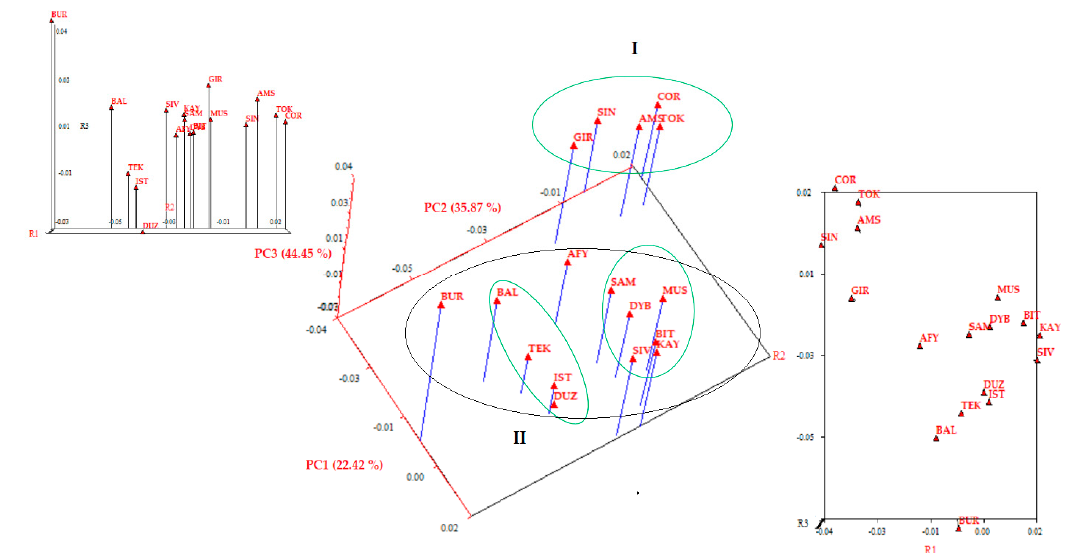
Figure 3. Tree ‐ dimensional principal component analysis (PCA) plot of Turkish water buffalo populations based on 20 microsatellite data. I Cluster I; II Cluster II; Marmara Region (MRM): İ stanbul/Çatalca ‐ IST; Tekirda ğ /Saray ‐ TEK; Bal ı kesir ‐ BAL; Bursa ‐ BUR; Black Sea Region (BSR): Düzce ‐ DUZ; Giresun ‐ GIR; Amasya ‐ AMS; Tokat ‐ TOK; Çorum ‐ COR; Sinop ‐ SIN; Samsun ‐ SAM; Aegean Region (AER): Afyon ‐ AFY; Central Anatolian Region (CAR): Kayseri (KAY), Sivas ‐ SVS; Eastern Anatolia Region (EAR): Mu ş‐ MUS, Bitlis ‐ BIT; South East Anatolian Region (SAR): Diyarbak ı r ‐ DYB.